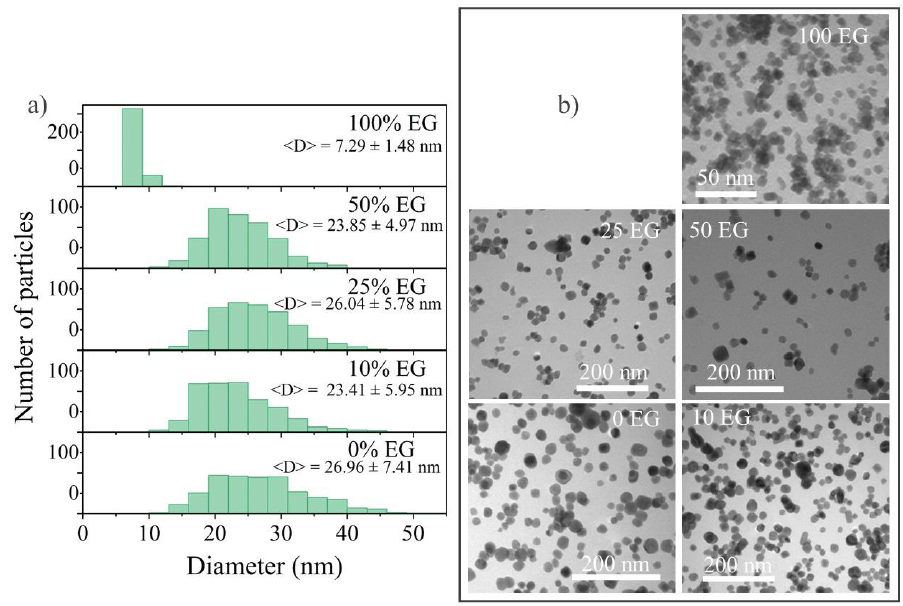
Figure 7. ( a ) Particle size distribution and <D> with the mean size ± standard deviation; ( b ) TEM images of 25Tb MW with different contents of EG 0, 10, 25, and 50%.